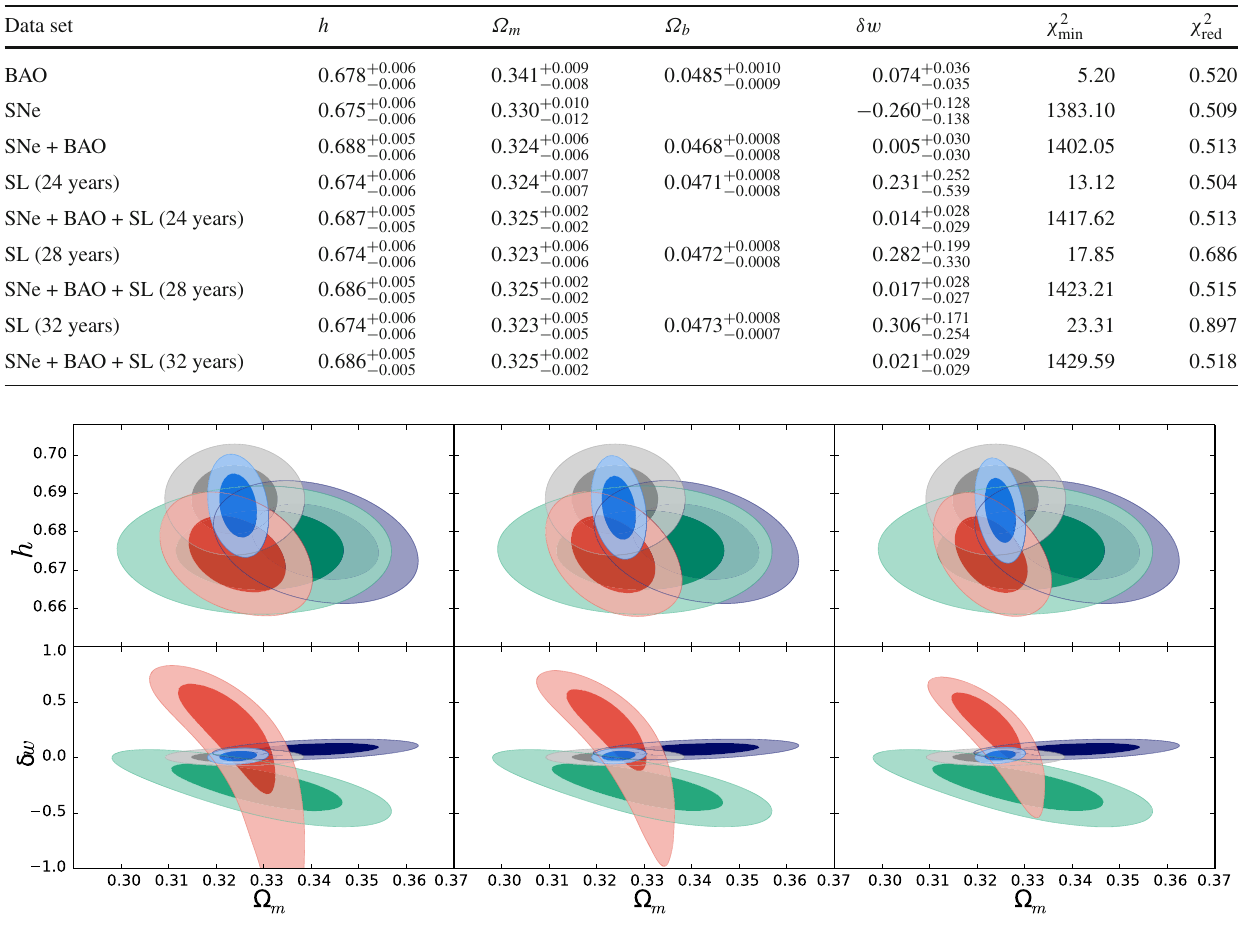
Fig. 6 Slow-roll model; solid contours limit 1 σ regions and clear contours 2 σ region. Purple for the BAO, green for SNe and red for SL data set, gray for SNe + BAO and blue SL + BAO + SNe. First set (left) for 24 years, second (middle) for 28 and third (right) for 32